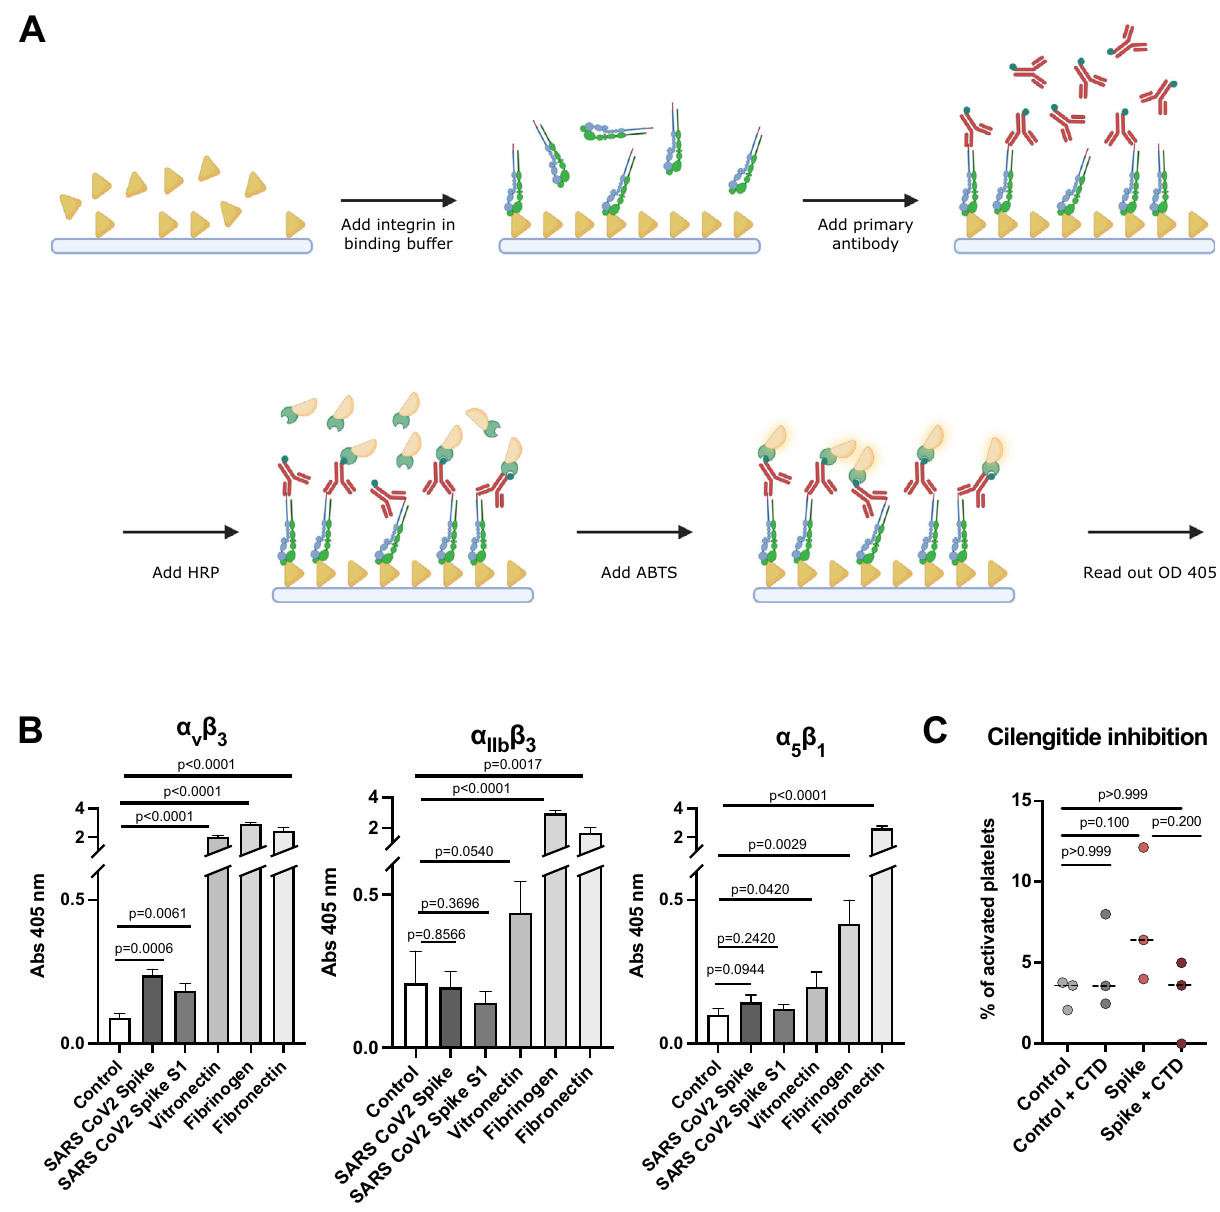
fi brinogen, α β fi bronectin. Data are from a representative experiment out of 5 1 - threeindependentones,andshownasmean±SD.Thesigni fi cancewasdetermined byantwo-tailedunpaired t test. C Quanti fi cationofplateletactivationonCollagenI depending on S protein concentration and integrin inhibitor cilengitide. The sig- ni fi cance was determined by a two-tailed Mann – Whitney U test. n =363 (control), n =278(control+CTD), n =339(+Spike), n =358(+Spike,+CTD)plateletsexamined overatleastthreeindependentexperimentsfromdifferentdonors.Sourcedataare available as a Source Data fi